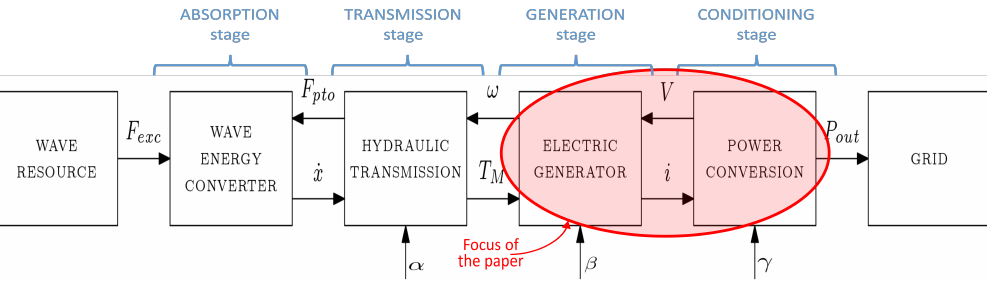
Figure 1. Full conversion chain of a wave energy converter with hydraulic power take-off (PTO); adapted from